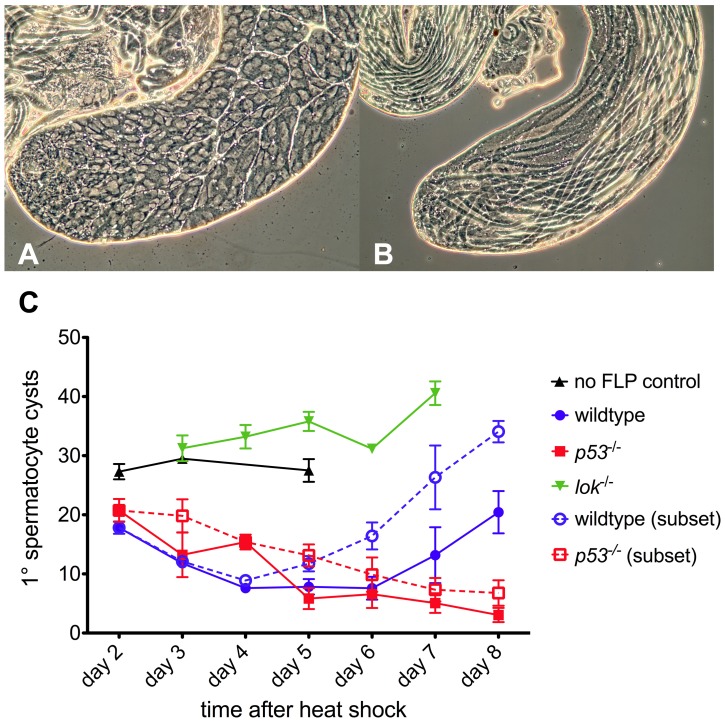
Primary spermatocyte cysts following dicentric chromosome induction.Phase contrast views of a normal testis and yw/DcY(H1); hsFLP2B/+ testis five days after heat shock. The apical portion of a normal testis (A) is filled with cysts, with primary spermatocyte cysts occupying most of the volume. Stem cells are located at the left tip. After dicentric induction (B) very few primary spermatocyte cysts are found (none in this particular testis). Instead, elongating spermatid cysts, derived from cells which were beyond the heat shock responsive stage [65], [66], occupy the entire length of the testis. (C) The primary spermatocyte cyst population after heat shock induction of dicentric chromosomes. Flies that do not make dicentrics (no FLP control, ▴) show no reduction of primary spermatocyte cysts after heat shock. After dicentric induction there is a reduction in primary spermatocyte cysts, followed by recovery in wildtype males (•), but not in p53 mutants (▪). The lok mutant males (▾) showed no reduction in primary spermatocyte cysts after dicentric induction. Dotted lines with open symbols represent data only for testes that had at least one primary spermatocyte cyst. Error bars indicate ±1 SEM.